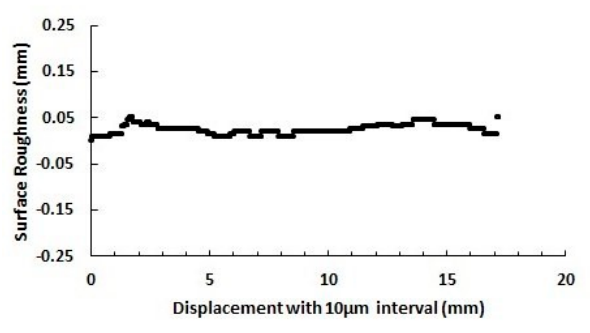
Figure 4. The surface roughness of the fabricated device with a displacement of 10 µm on a 20 mm long surface.